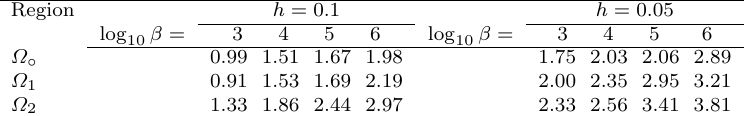
Table 2. Comparing − log 10 ( r.l.s.e ) errors for δt = 0 . 01 by different parameters β and h for non-uniform gird points and different domains. Region h = 0 . 1 h = 0 . 05 log 10 β =